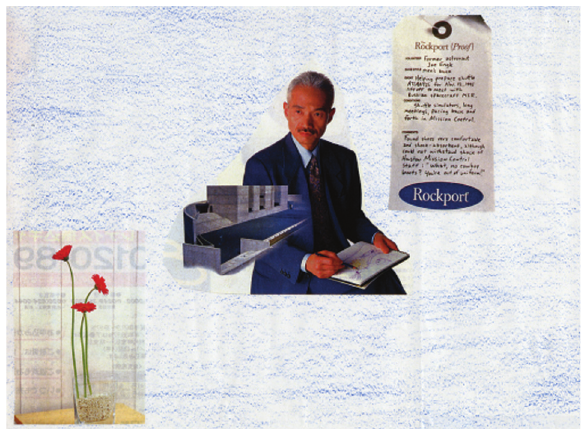
Figure 2. Theme: school and teacher.